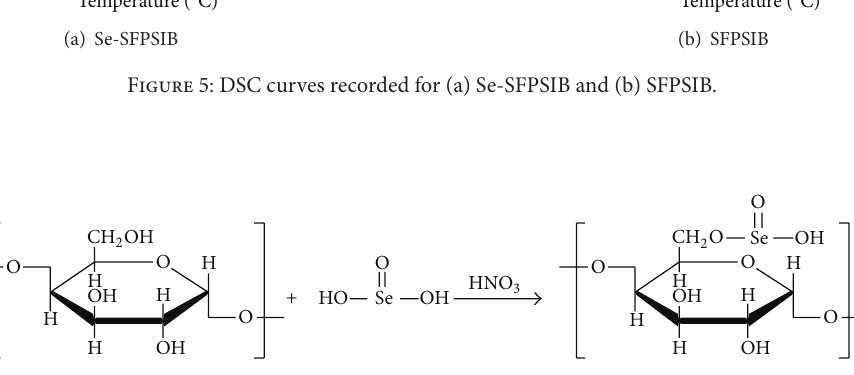
Figure 6: Selenylation mechanism of